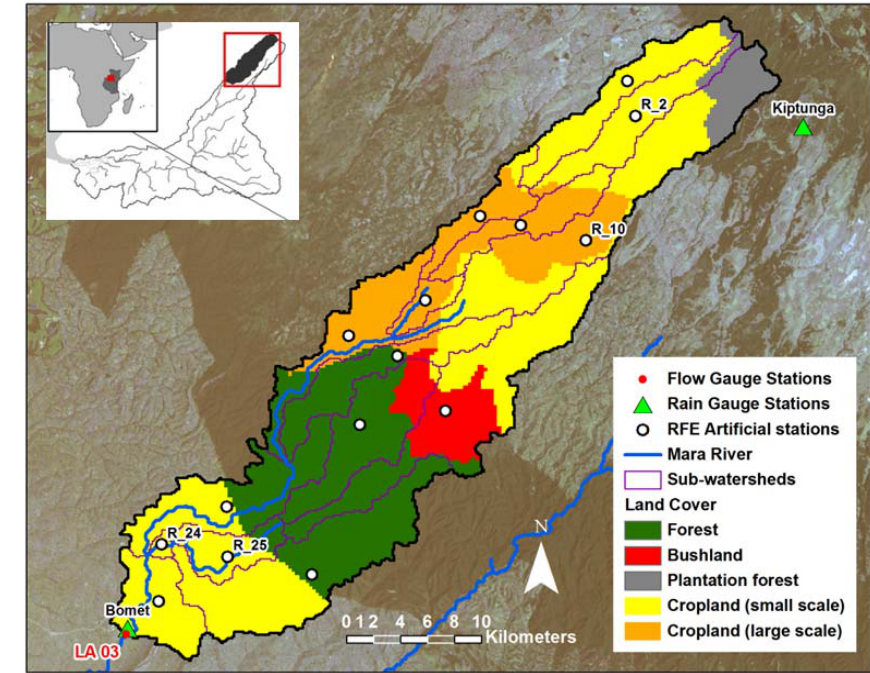
Fig. 1. Nyangores sub-basin, upper Mara River basin, Figure 1. Nyangores sub-basin, upper Mara River basin, Kenya.